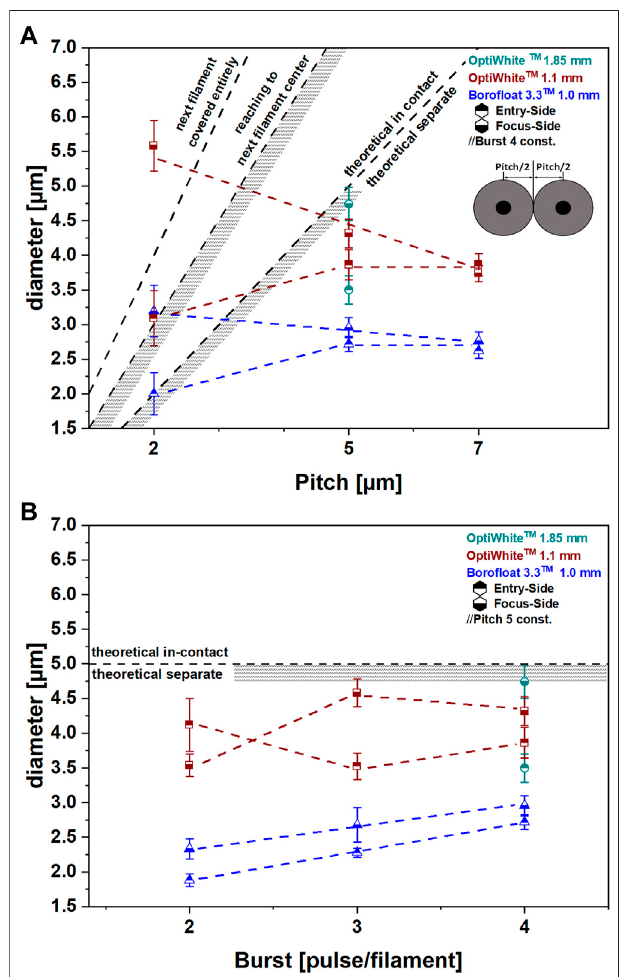
FIGURE 4 | Surface modi fi cation diameter measured from SEM images inrelationtothePitch (A) andtotheBurst (B) .Smallsketchin (A) illustratesthe criteria of surface modi fi cations being in contact with a diameter/Pitch ratio of 1:1. Further critical thresholds are displayed with a 1.5:1 ratio marking theborderwhensurfacemodi fi cationsreachintotheadjacentcenterposition, or with a 2:1 ratio when the surface modi fi cations cover the adjacent fi lament entirely. The blurred regions attached to the thresholds resemble the viscous behaviorofthesurfacemodi fi cations. Ingeneral,OptiWhite ™ isforming larger surfacemodi fi cationsthanBoro fl oat3.3 ™ .AtoonarrowPitchcausedmelting andexceedinglylargesurfacemodi fi cations,whereastheBurstshowedminor in fl uence on the modi fi cation